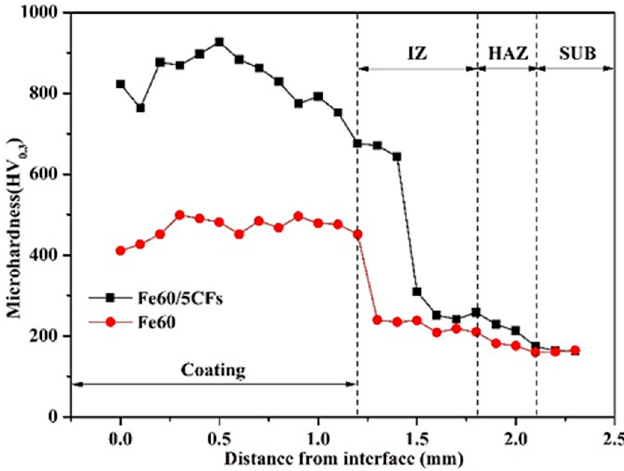
Figure 12. Micro-hardness profile of the transverse cross-section of the composite coatings.